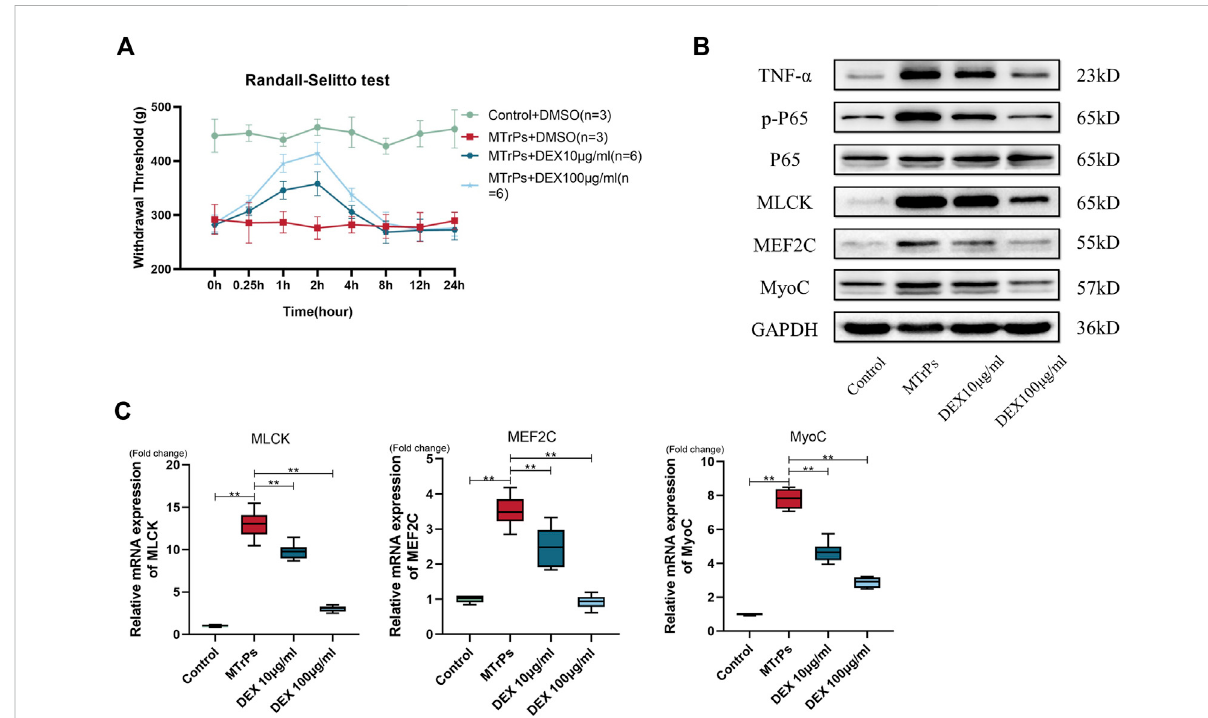
FIGURE 6 (A) Effect of DEX on mechanical withdrawal threshold in MTrPs group rats. Increased mechanical withdrawal threshold in MTrPs rats ( n = 6) at 1and 2 hafter intramuscularinjectiontwo concentrationsofDEX(10ug/ml and 100ug/ml). (B) . The expression ofTNF- α , p-P65, P65, MLCK, MEF2C, and MyoC was detected 2 h after injection of two different concentrations of dexmedetomidine (10 μ g/ml and 100 μ g/ml) into the gastrocnemius muscle of MTrPs rats, and the protein levels were found to be signi fi cantly inhibited. (C) . The mRNA expression levels of MLCK, MEF2C, and MyoC were signi fi cantly lower than those of the MTrPs group after dextromethorphan injection, with GAPDH as the internal reference mRNA. * p < 0.05, ** p <